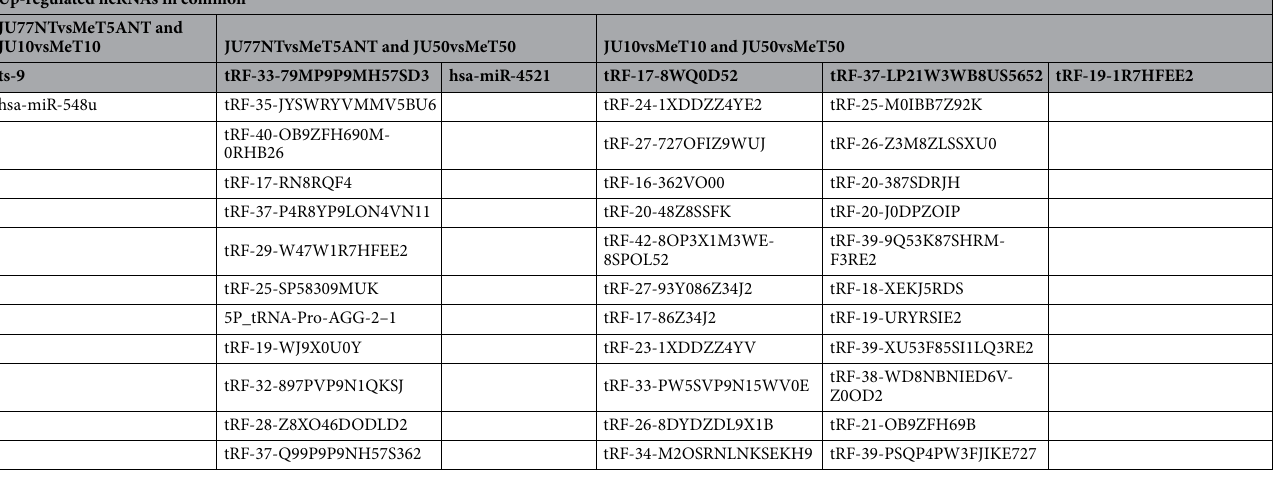
Table 3. Up-regulated ncRNAs in common among JU77 (human malignant mesothelioma) vs. MeT-5A (human normal mesothelium) controls and JU77 vs. exposed to 10 and 50 ug/ml FE fibers; down-regulated ncRNAs in common among JU77 vs. MeT-5A exposed to 10 and exposed to 50 ug/ml FE